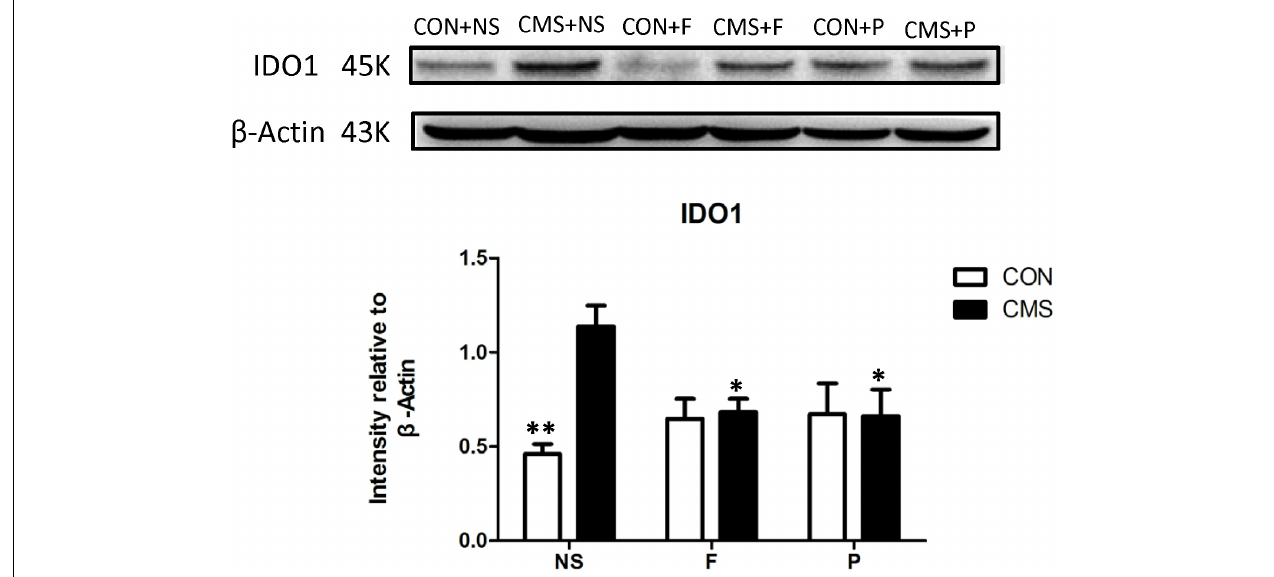
FIGURE 5 | IDO1 protein levels in the hippocampus. Above: western blots for IDO1. Below: ImageJ analysis of IDO1 protein intensity normalized to β -actin; n = 4 per group; ∗ P < 0.05; ∗∗ P < 0.01.